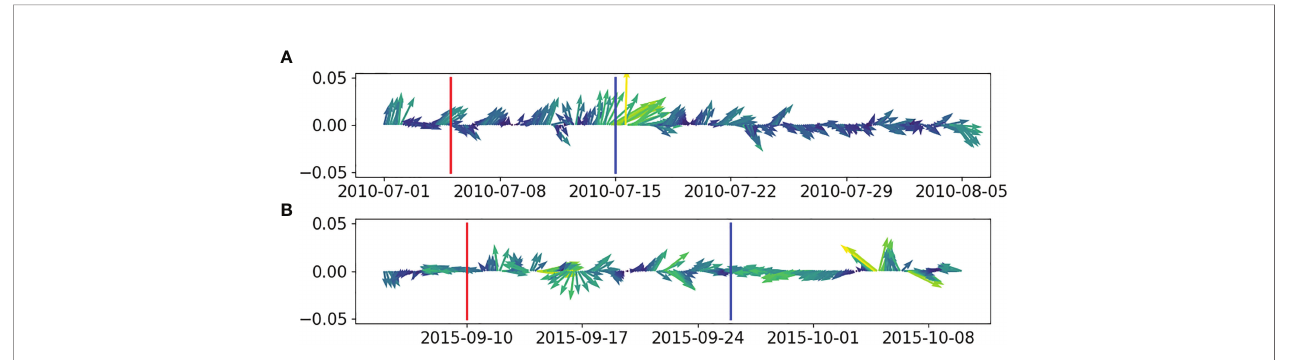
FIGURE 10 | Wind velocities during the PML model drifts in 2010 (A) and 2015 (B) . In both years the red line indicates the fi rst particle release and the blue the